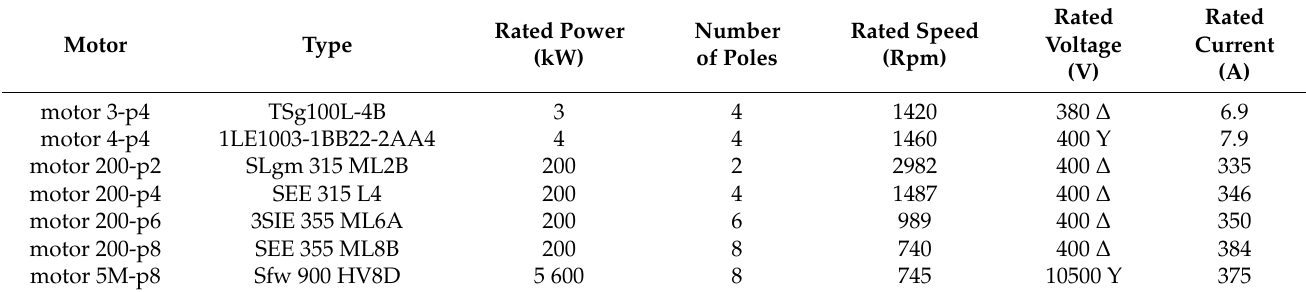
Table 1. Basic parameters of the investigated